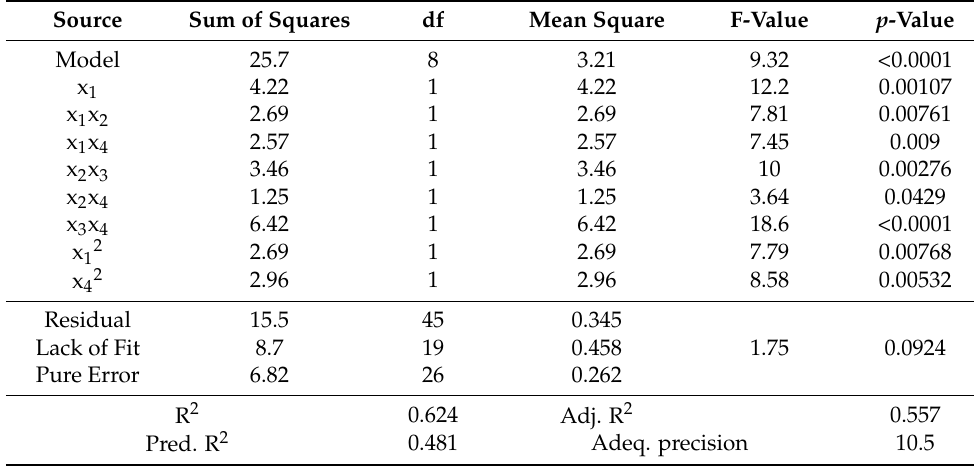
Table 4. ANOVA for response surface quadratic